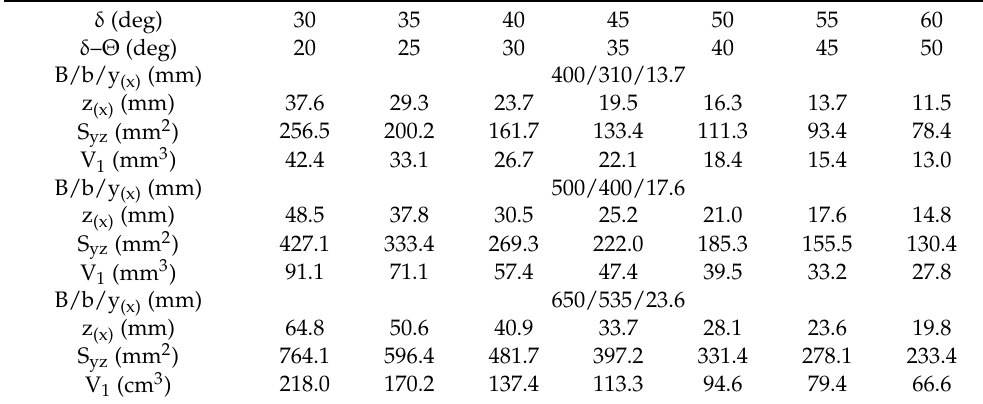
Table 1. Lengthwise distance, surface, and volume of a batch of loose material.